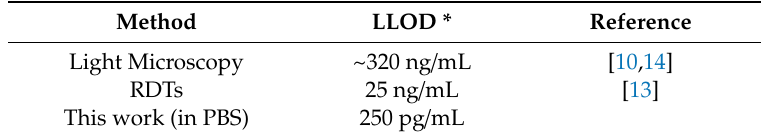
Table A1. Comparison of lower limit of detections (LLODs) of current best-practice malaria diagnostic